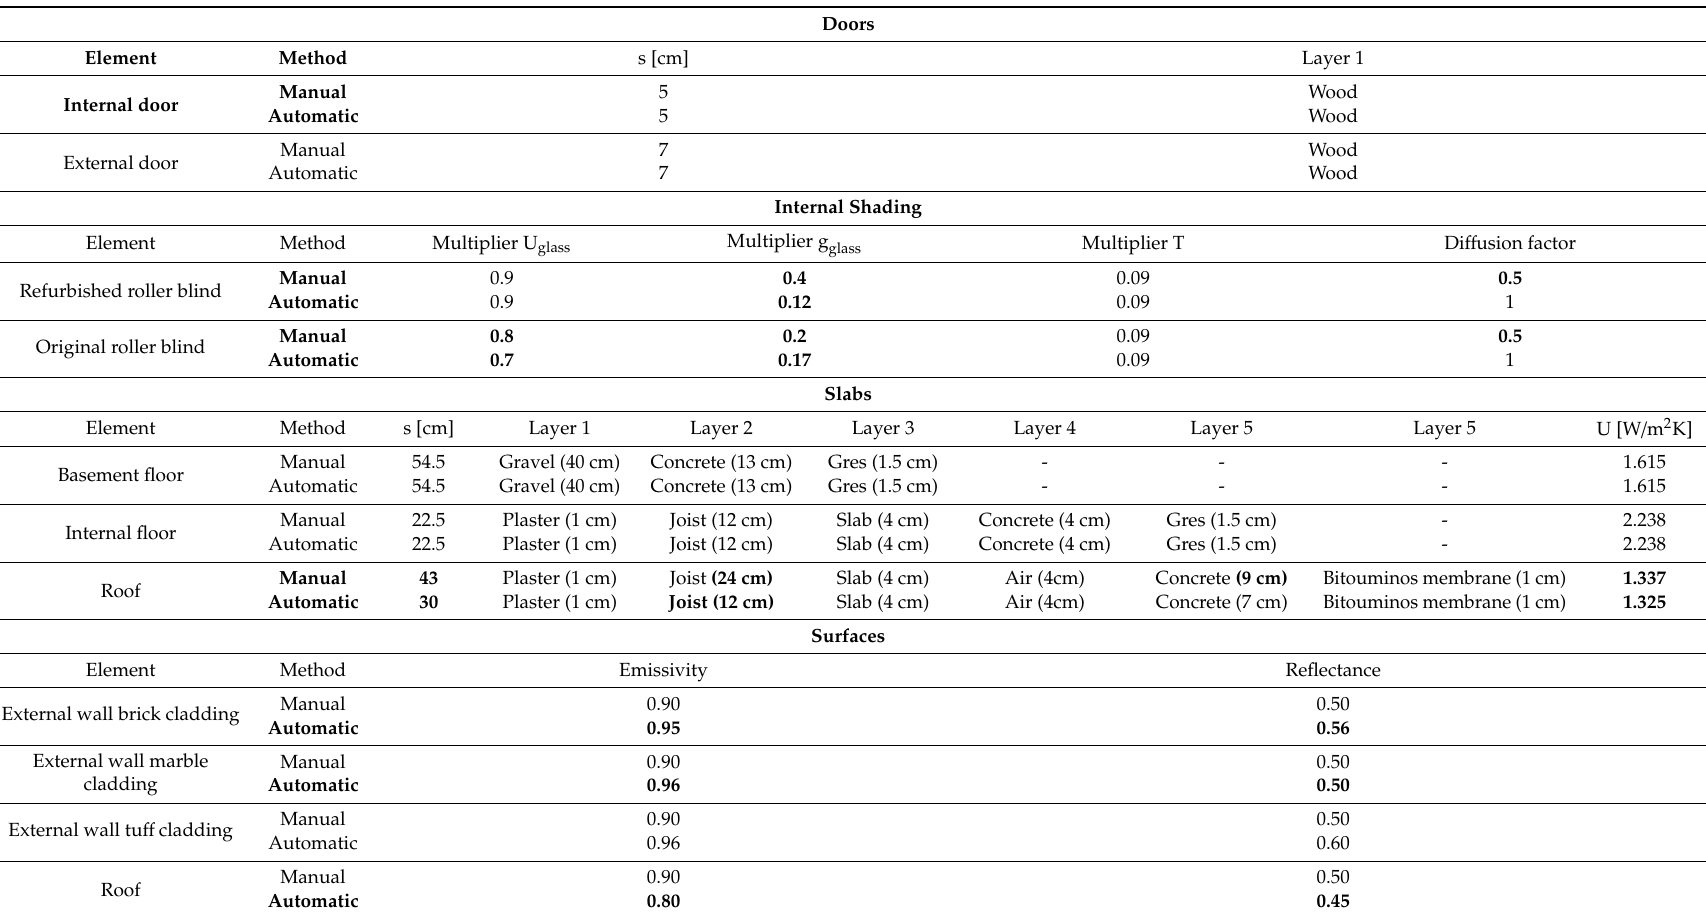
Table 14. Construction elements for resulting models from manual and automatic calibration (bold when